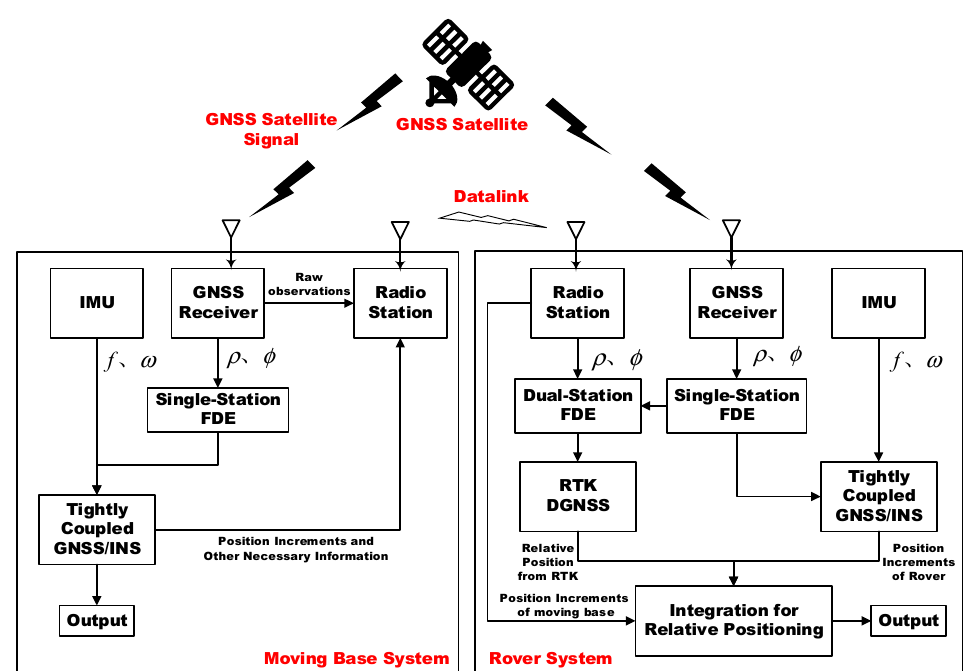
Figure 1. Overall architecture. The integration mechanism of the synchronous relative position is displayed in Figure 2. In the figure, the horizontal axis with arrows denotes the observation time axis; t 0 and t i denote the first and i -th observation times, respectively, when the RTK DGNSS relative positioning succeeds; ∆ t p denotes the time interval for predictions of position increments of the moving base; ∆ t TC denotes the time interval of measurement updates in the TC-GNSS/INS integration algorithm, which is assumed to be the same value in the rover and the moving base. Once RTK DGNSS relative positioning succeeds at t 0 and t i , precise baseline vectors d X rb , t and d X rb , t between the rover and moving base can be obtained, represented by red dashed vertical arrows in Figure 2. Position increments from t i to t i + ∆ t TC can be calculated and saved in a buffer in the rover and moving base independently at t i + ∆ t TC , which are denoted as d X r , ∆ t and d X b , ∆ t , represented by black curved dotted arrows in Figure 2. Then, position increments of the moving base, namely d X b , ∆ t , are broadcast to the rover. Assuming that the current observation time is t i + ∆ t TC + ∆ t p , when the nearest RTK DGNSS relative positioning succeeding time is t i and the time of the latest position increments received from the moving base is t i + ∆ t TC , the integrated synchronous relative position can be expressed as where d X rb , t denotes the integrated synchronous relative position at t i + ∆ t TC + ∆ t p , which is represented by solid arrows in Figure 2; d X r , ∆ t denotes the position increment of the rover from t i + ∆ t TC to t i + ∆ t TC + ∆ t p , which can be obtained from the TC-GNSS/INS integration algorithm of the rover; d X b , ∆ t denotes the predicted position increment of the moving base from t i + ∆ t TC to t i + ∆ t TC + ∆ t p by the polynomial prediction algorithm based on historic broadcasted position increments in a sliding window.